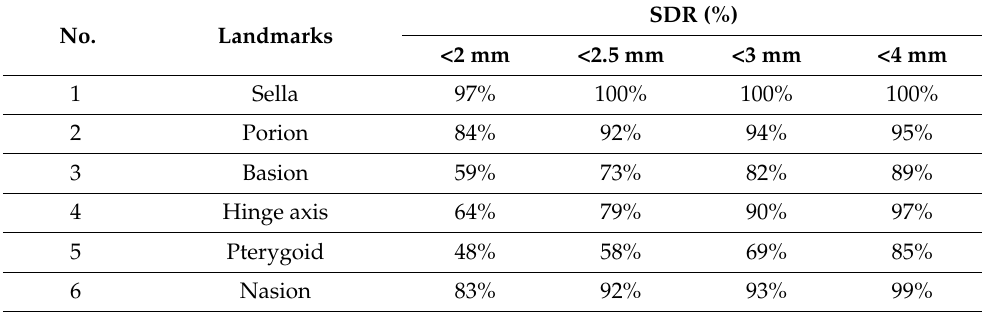
Table 3. Results of landmark detection in terms of successful detection